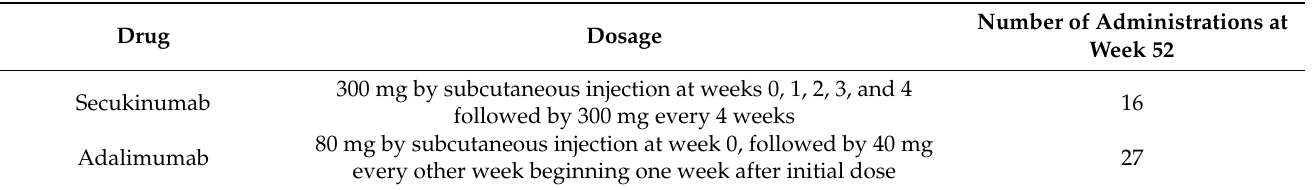
Table 2. Number of administrations of secukinumab and adalimumab at week